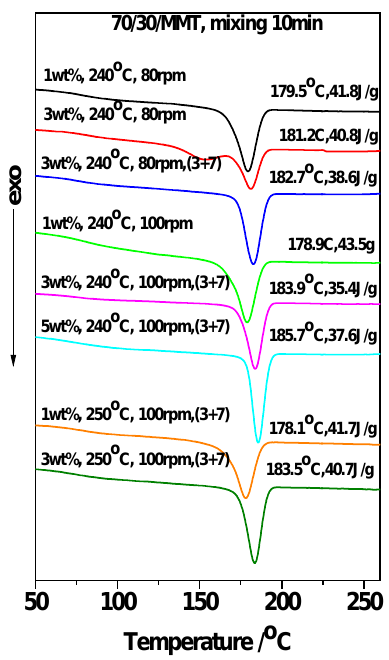
Figure 10. Influences of the MMT (Cloisite ® 25A) content on the crystallization of the 70/30/1 wt. % PTT/PC/MMT blend processed at indicated temperatures, shears and processing modes.